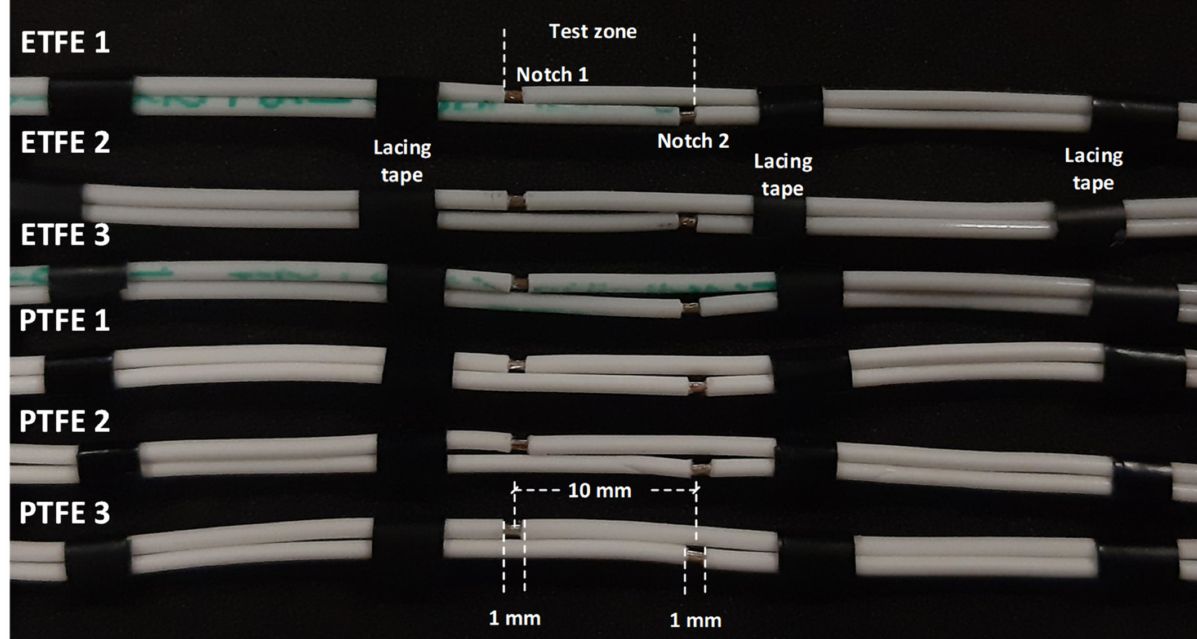
Figure 1. ETFE- and PTFE-insulated pairs of wire samples analyzed in this work. A notch made in each wire sample, 1 mm wide and 10 mm apart from the notch of the mating wire. The mating wires were fastened using lacing tapes to ensure the wires are straight and parallel, while ensuring continuous contact within the test zone.